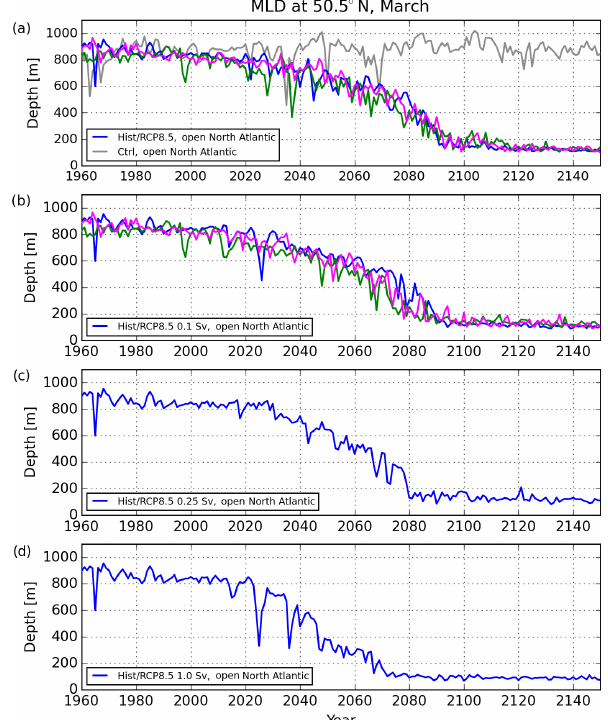
Figure A6. March MLD in the NE Atlantic (50.5 ◦ N, 15–20 ◦ W, thick lines) for the control run C0 (gray) and individual realizations (blue, green, magenta) of experiments E0 (a) , E010 (b) , E025 (c) and E100 (d)